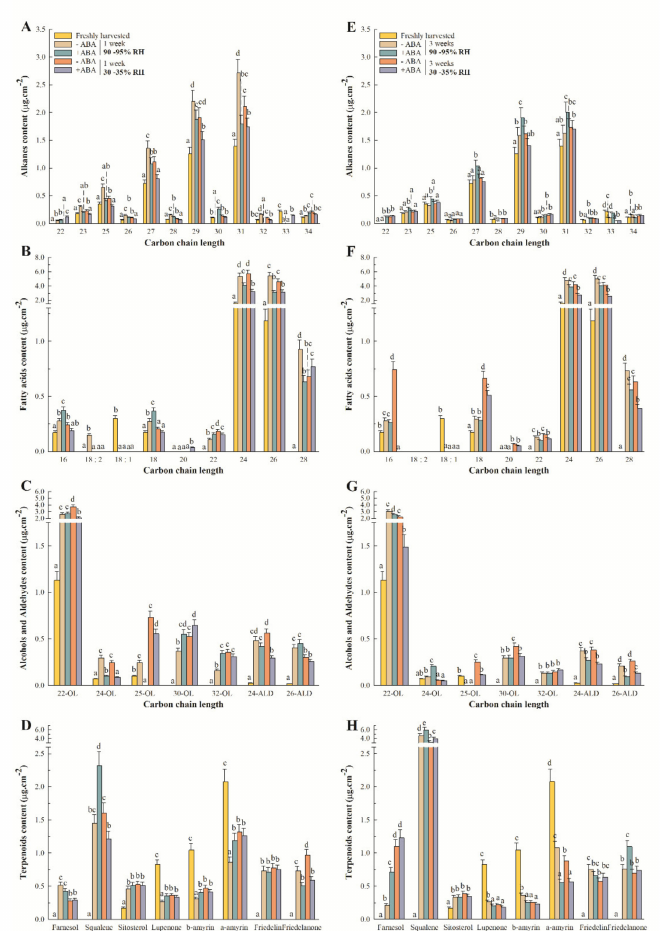
Figure 3. Effect of ABA and water stress on epicuticular wax constituents during Pinalate fruit storage. The effects of ABA (1 mM) treatment on the content of the epicuticular wax components were evaluated together with the influence of high (90–95%) or low (30–35%) RH by 1 ( A – D ) and 3 ( E – H ) weeks at 20 ◦ C. ( A , E ) Alkanes; ( B , F ) fatty acids; ( C , G ) alcohols and aldehydes; and ( D , H ) terpenoids. Bars are the means ± SD of four replicates per condition. Different letters above the bars indicate significant ( p < 0.05) differences among conditions according to an ANOVA analysis followed by a Tukey test ( p < 0.05) for each component and storage time